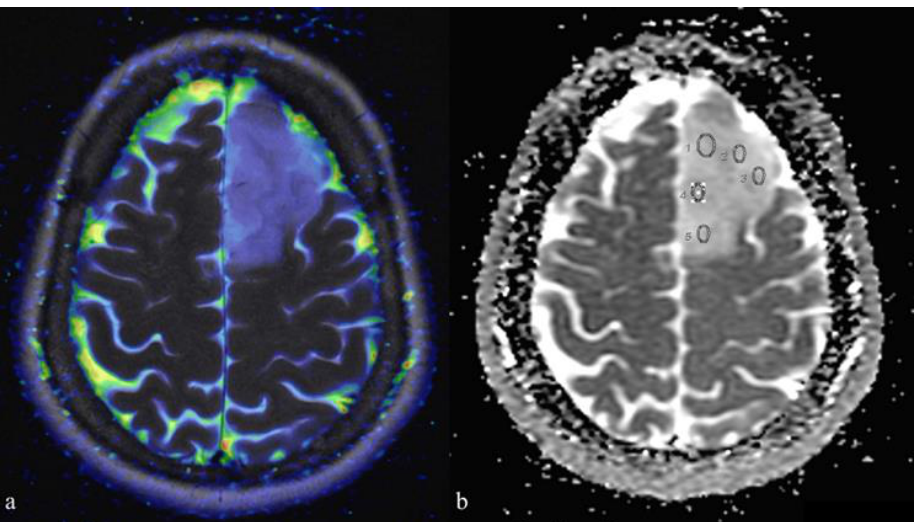
Figure 1. Placement of region on interests (ROIs) on the apparent diffusion coefficient (ADC) map: ( a ) co-registration between T2-weighted and color-coded ADC map (blue: restricted diffusion; red: facilitated diffusion); ( b ) placement of five elliptical ROIs on parametric ADC map within the tumor. Co-registration allows identification of the different components of the tumor and peritumoral region. Scale bar: 5 cm.